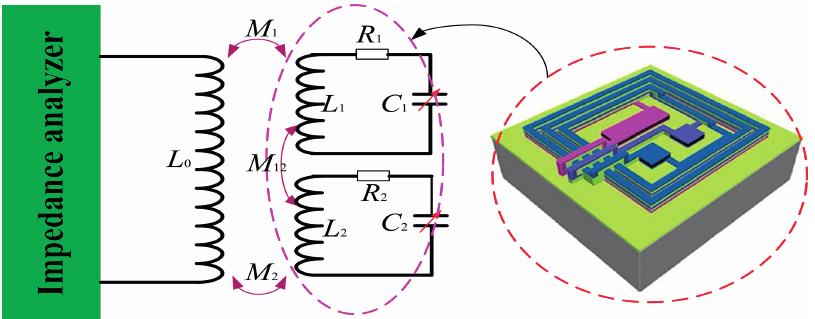
Figure 6. Model of a passive LC sensor capable of simultaneously measuring multiple